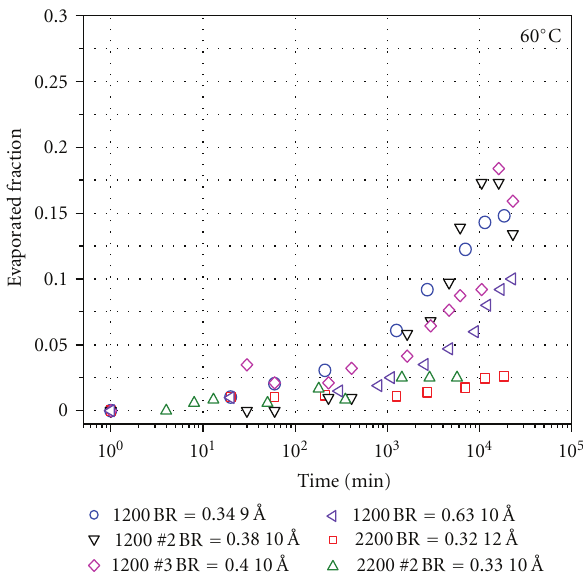
Figure 7: Evaporative loss of 9–12 ˚A Z-Tetraol films on CN x at 60 o C. The experiments were repeated more than several times as a check of consistency. The inset legend specifies the MW (1200 or 2200), the bonded ratio (BR) when the experiment was begun, and the initial film thickness (9–12 ˚A). The bonded ratio was varied by disk aging under ambient conditions; that is, no annealing or UV treatment was applied to the disks.